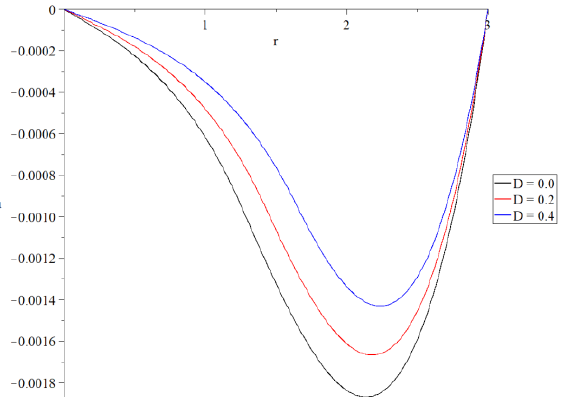
Figure 10. The distribution of the displacement for the variance values of mechanical damage parameter in the context of the hyperbolic two-temperature model.